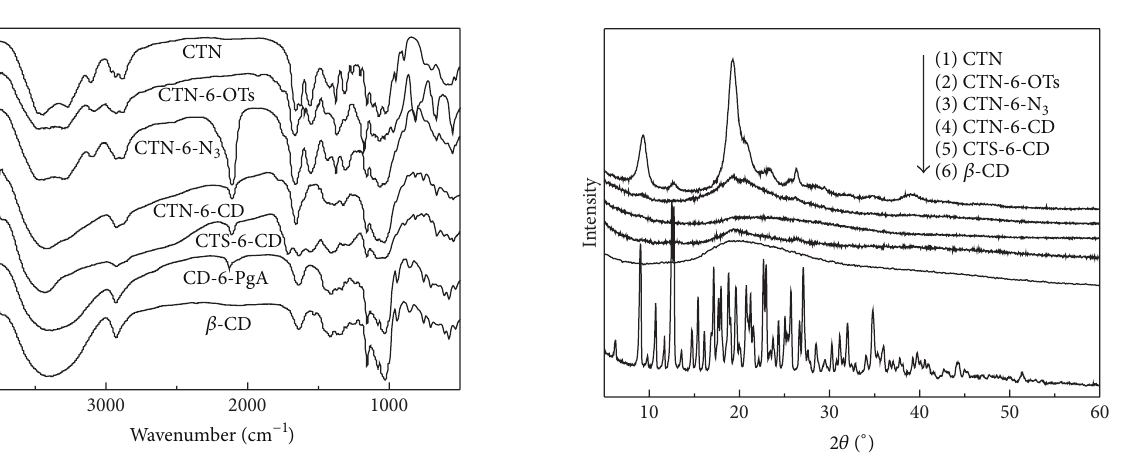
Figure 3: XRD patterns of the synthesized products in the